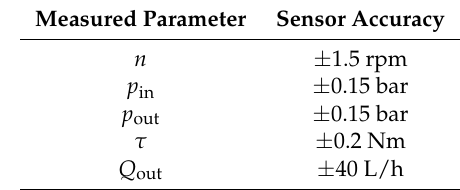
Figure A1. Test rig schematic. Table A1. Sensor accuracy.